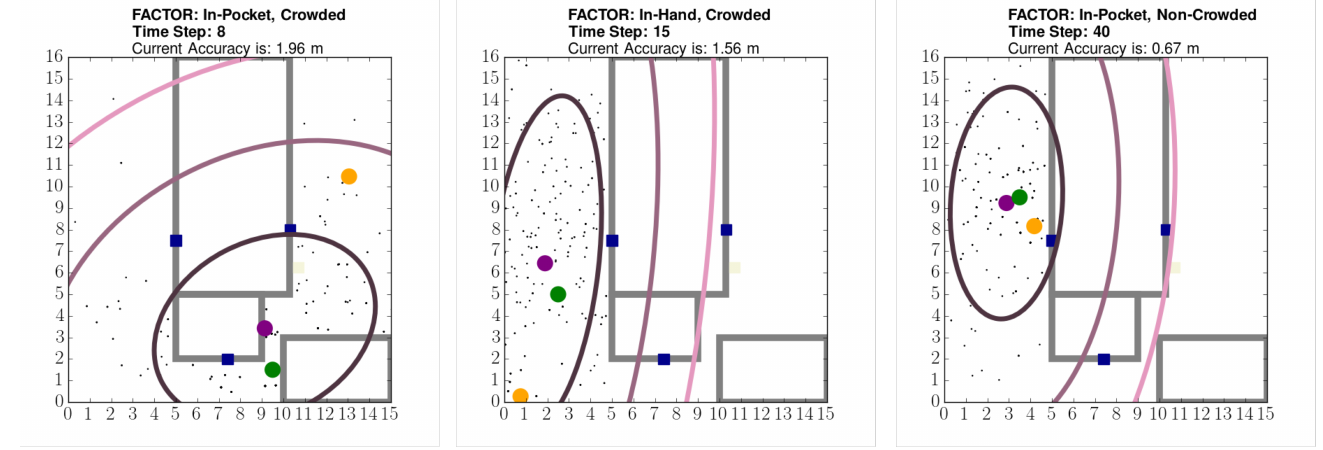
Figure 12. Example screens from the